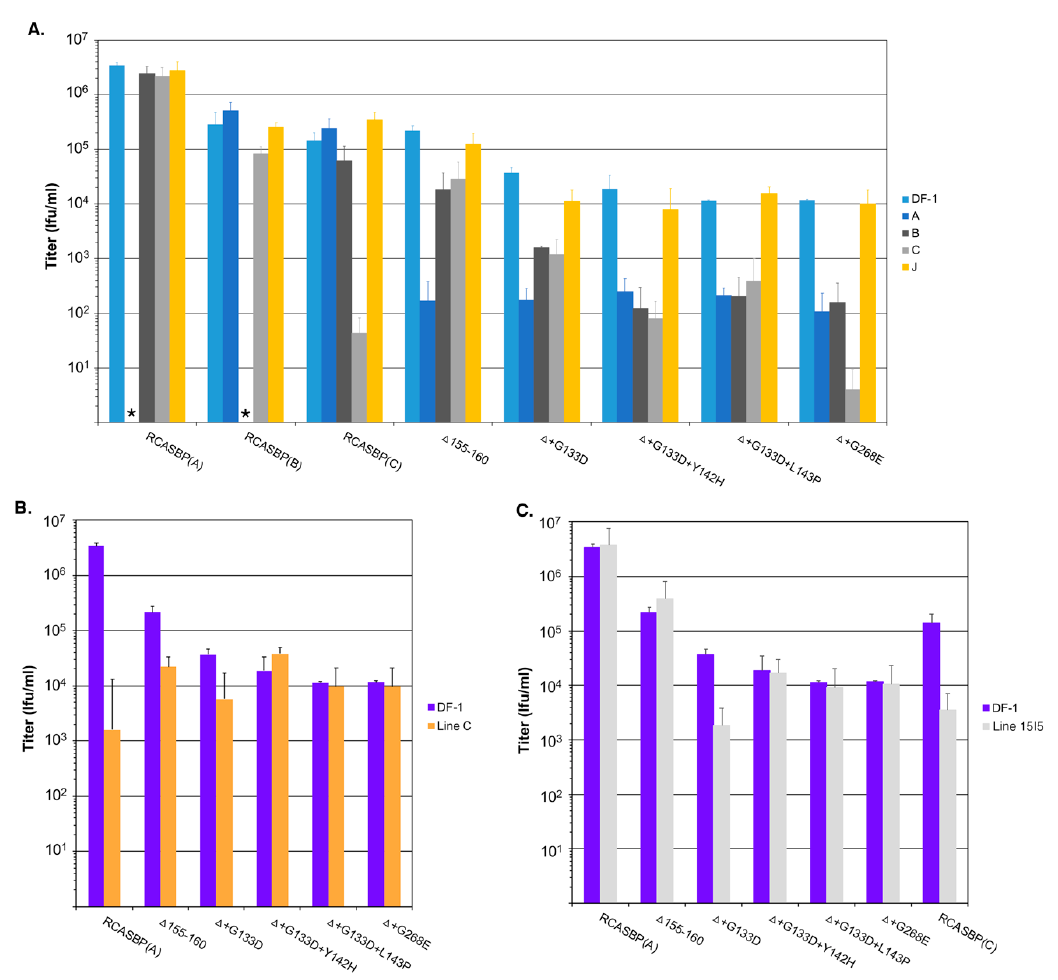
Figure 4. Analysis of receptor usage of the parental ∆ 155–160 and ∆ 155–160 mutant viruses. Infectious titers were determined using 10-fold serial dilutions of wild-type RCASBP(A), RCASBP(B), and RCASBP(C) viruses, the parental ∆ 155–160 virus, and the ∆ 155–160 mutant virus supernatants produced using DF-1 cells. The infectious titer was determined by the AP assay. No infectious units detected are denoted with ( ∗ ). The results shown are an average of three different experiments; error bars show standard deviations. ( A ) ASLV receptor interference patterns of the ASLVs infecting parental DF-1 cells, and DF-1 cells chronically infected with ASLV(A), ASLV(B), ASLV(C), or subgroup J ASLV, HPRS103. ( B ) The infectious titers of the ASLV viruses were determined using Line C CEFs that do not express a functional Tva receptor. ( C ) The infectious titers of the ASLV viruses were determined using Line 15I5 CEFs that do not express a functional Tvc receptor.